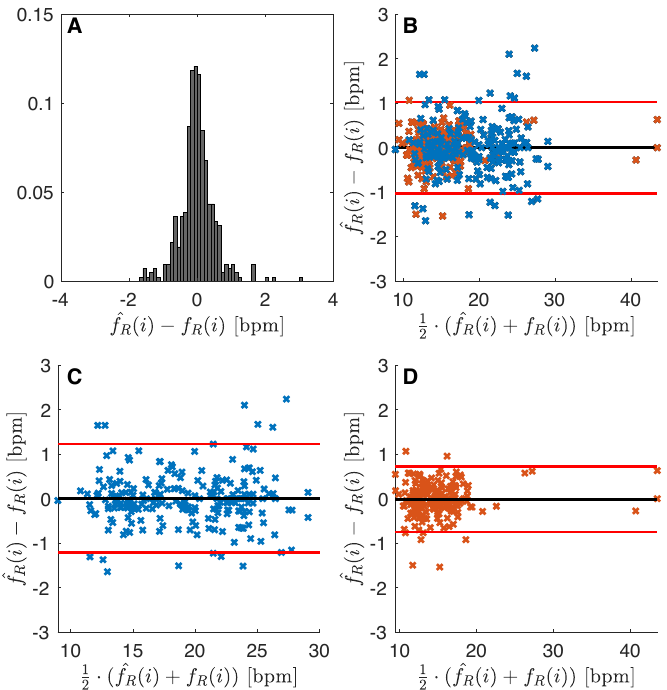
Figure 5. ( A ) Difference distribution between proposed method and reference respiratory rate values; ( B ) Bland–Altman plot obtained considering all the data recorded by male and female volunteers: black line is the MOD, red lines are the LOAs (i.e., ± 1.96 times the standard deviation); ( C , B ) Bland–Altman plot obtained considering data recorded by male volunteers; ( D ) Bland–Altman plot obtained considering data recorded by female volunteers.